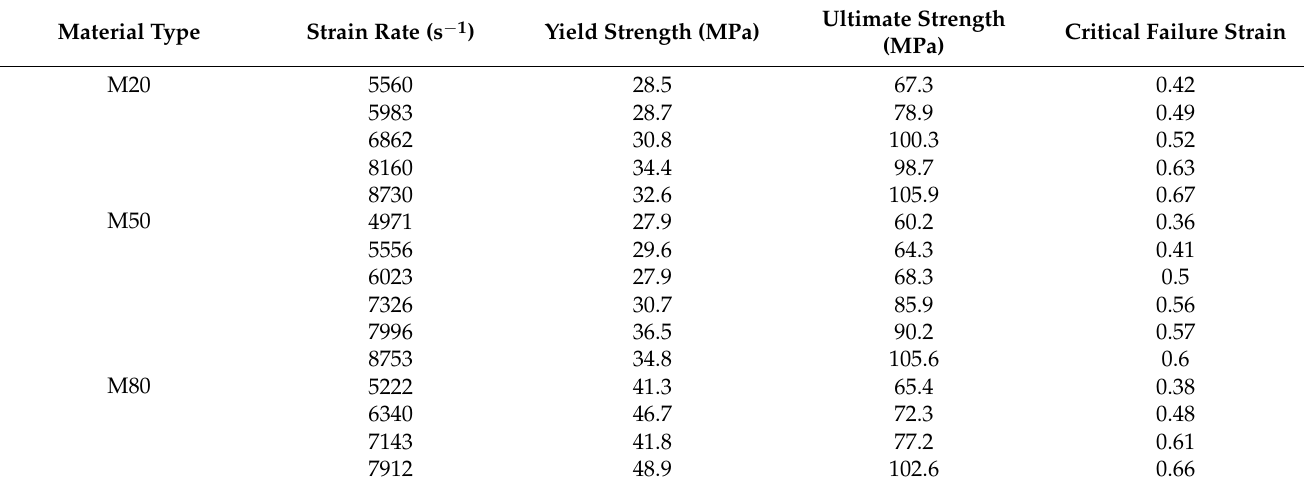
Figure 13. Typical recycled residues after dynamic compression. Table 3. Characteristic parameters of the Al-PTFE-W materials at elevated strain rates.